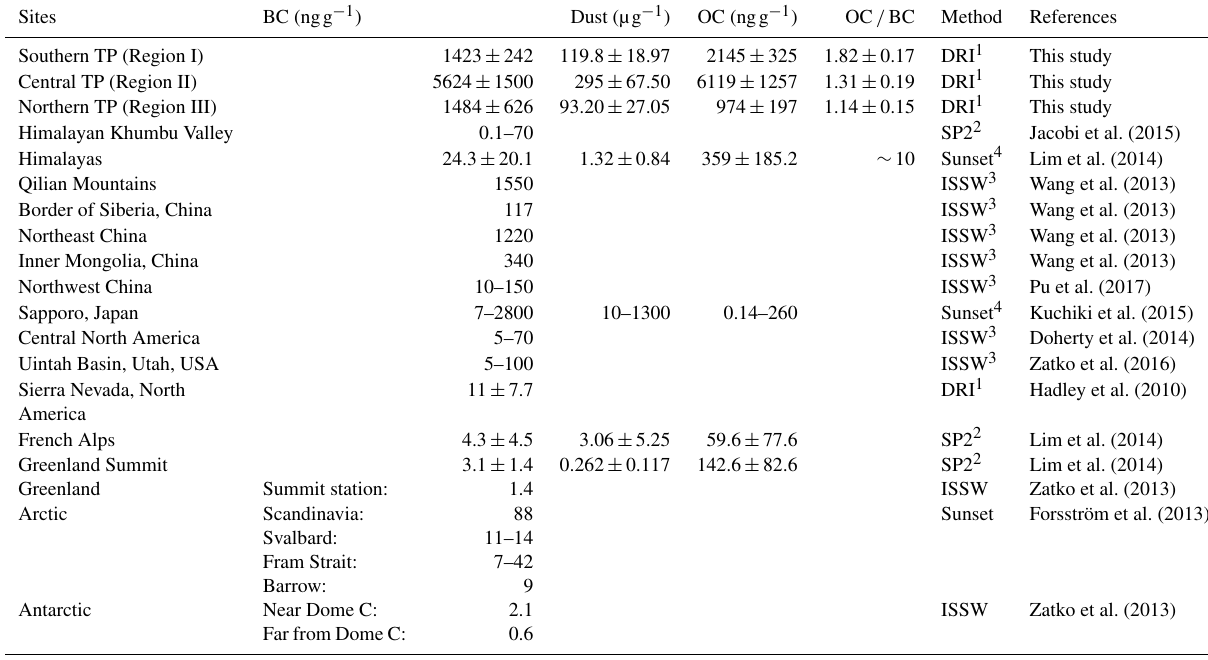
Table 2. Summary of BC, OC, and dust concentrations in snow over the Tibetan Plateau and other regions.